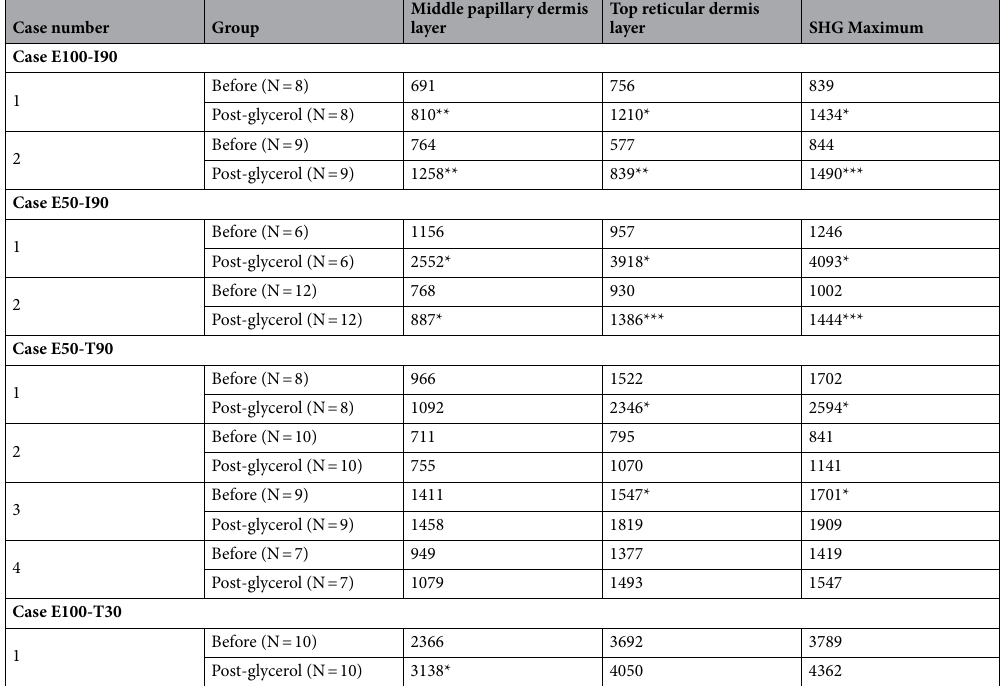
Table 5. Mean SHG intensities (arbitrary unit) of all studied cases at the middle papillary dermis layer, top reticular dermis layer, and SHG maximum layer. (*P < 0.05, ** P < 0.01, *** P <